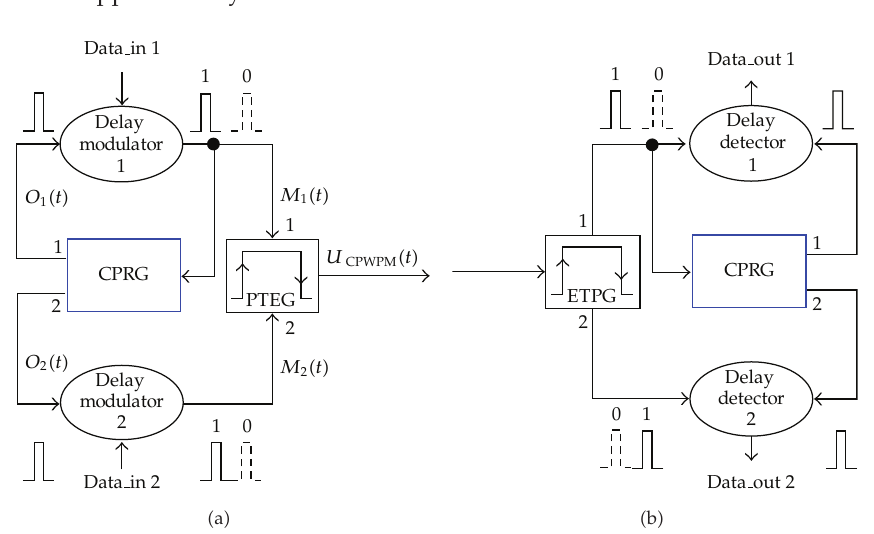
Figure 1: (cid:2) a (cid:3) Modulation scheme, (cid:2) b (cid:3) demodulation scheme.